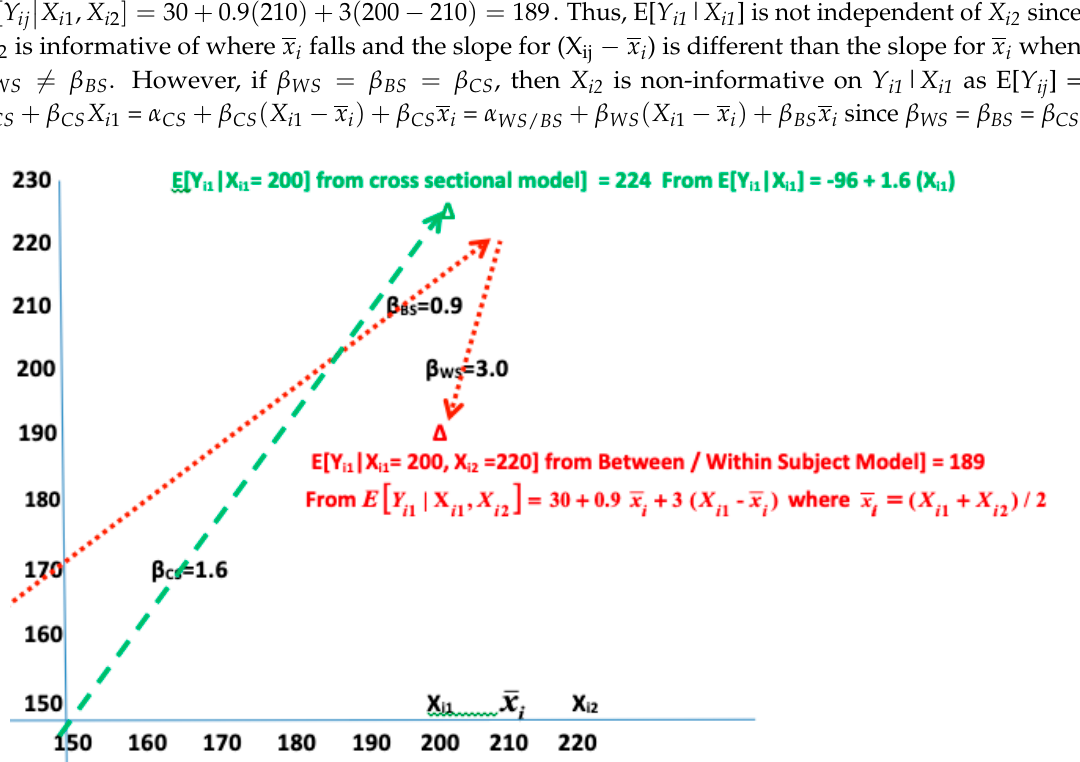
Figure A1. Illustration that E{Y i1 } X i1 } is not independent of X i2 in Cross ‐ sectional regression for K =